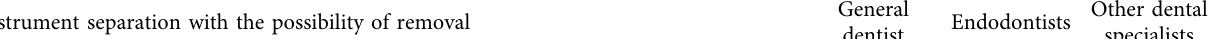
Table 4: Frequency of respondents when related to their conduct in case of instrument separation with the possibility of fragment removal ( p ≥ 0.05). Instrument separation with the possibility of